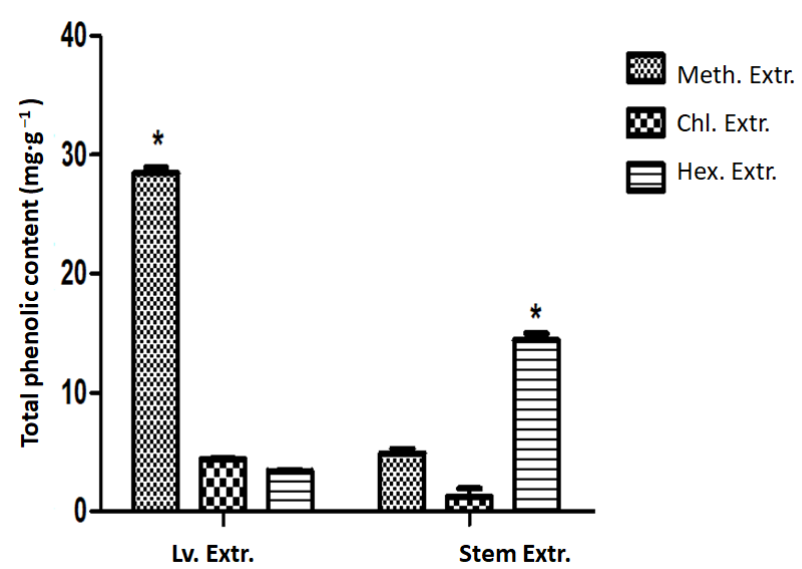
Figure 5. Total phenol content of the solvent extracts of both D. villosa leaves and stem bark. F (2, 6) = 225.8, p ≤ 0.0001. * (methanol vs. chloroform), p < 0.05. * (hexane vs. methanol), p < 0.05. Values are expressed as means ± SEM; n = 3/group. Chl. = Chloroform; Hex = Hexane, Meth. = Methanol; Lv. = leaves; Extr. = Extract.